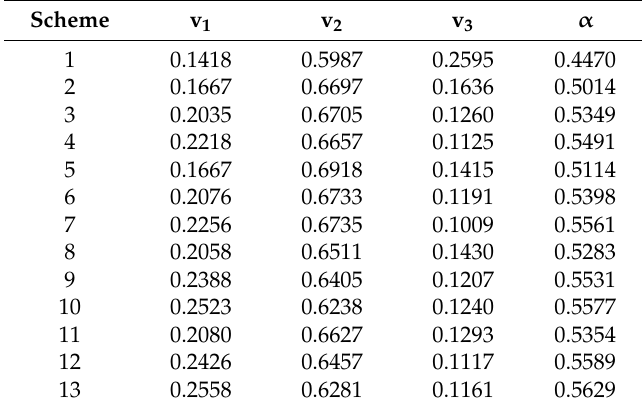
Table 7. Comprehensive evaluation of WRCC in the middle reaches of Heihe